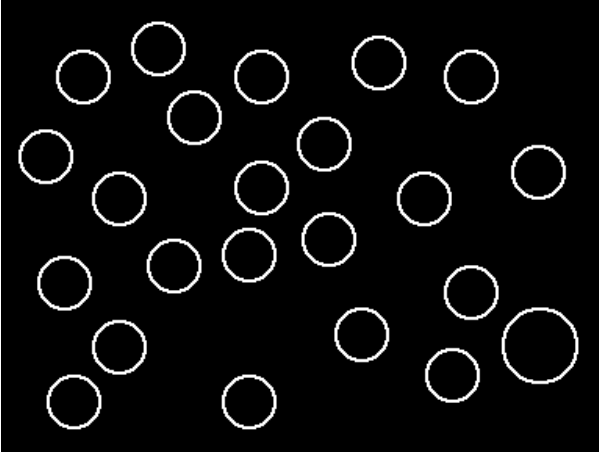
Figure 3. Schematic example task of the SuRT. Participants had to react to the larger circle.